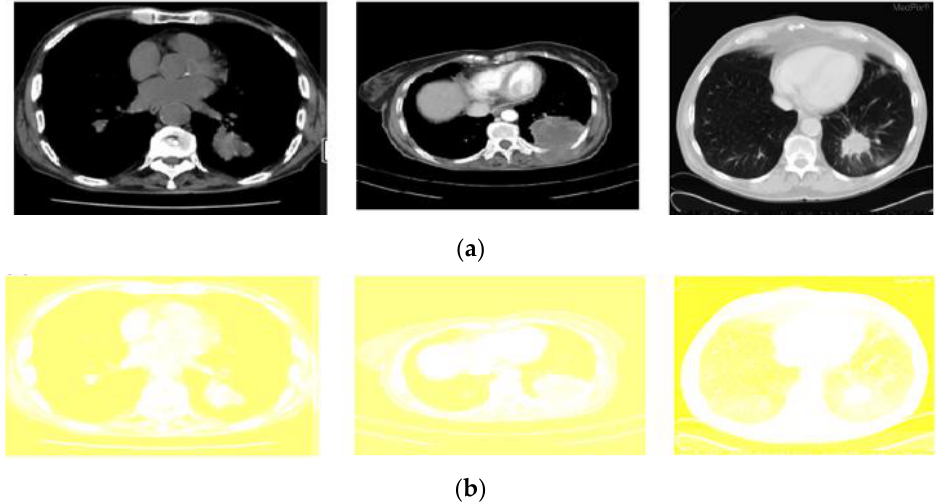
Figure 5. Output of the pre-processed images: ( a ) The original input images ( b ) corresponding results of modified color-based histogram equalization.